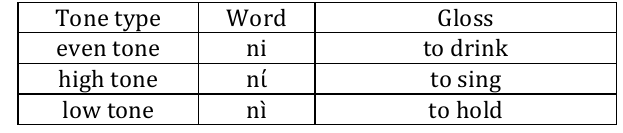
Table 6: Three tones in Deori as posited by Goswami (1984)